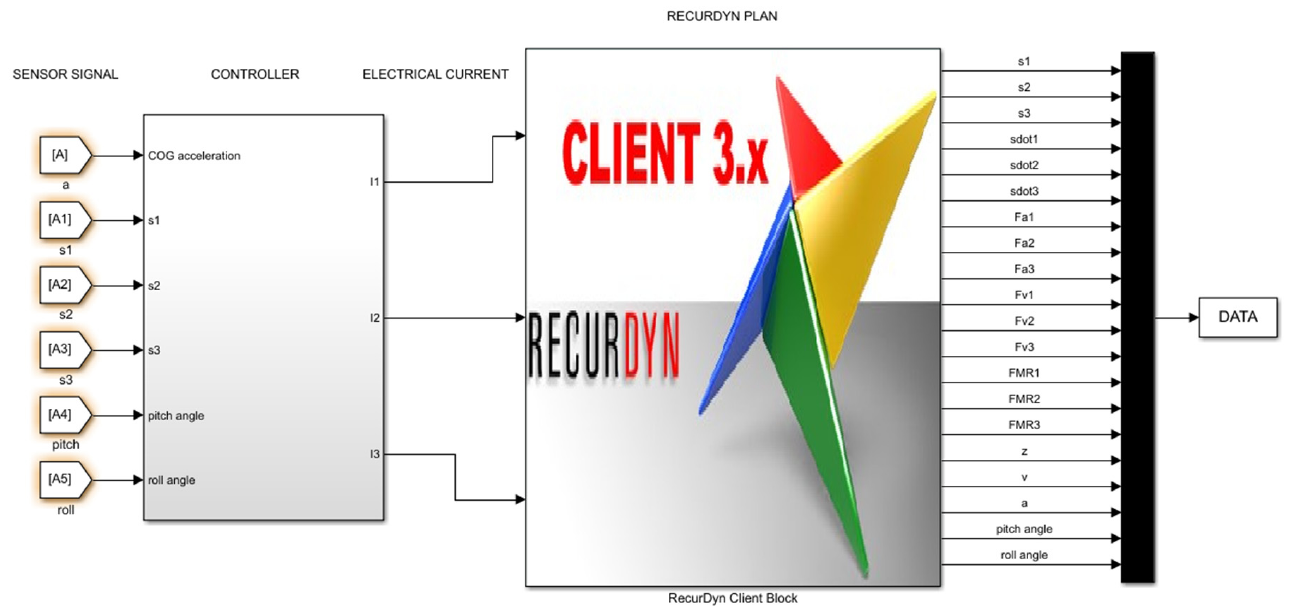
Figure 12. Co-simulation between MATLAB – RECURDYN.